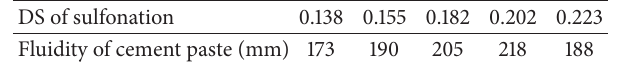
Table 2: Effect of the DS of sulfonation on the fluidity of cement paste. DS of sulfonation